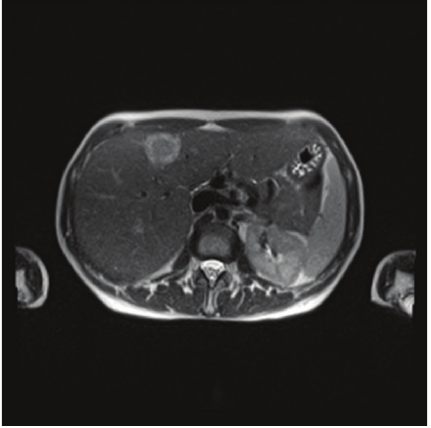
Figure 3: T2 hyperintense liver lesion on